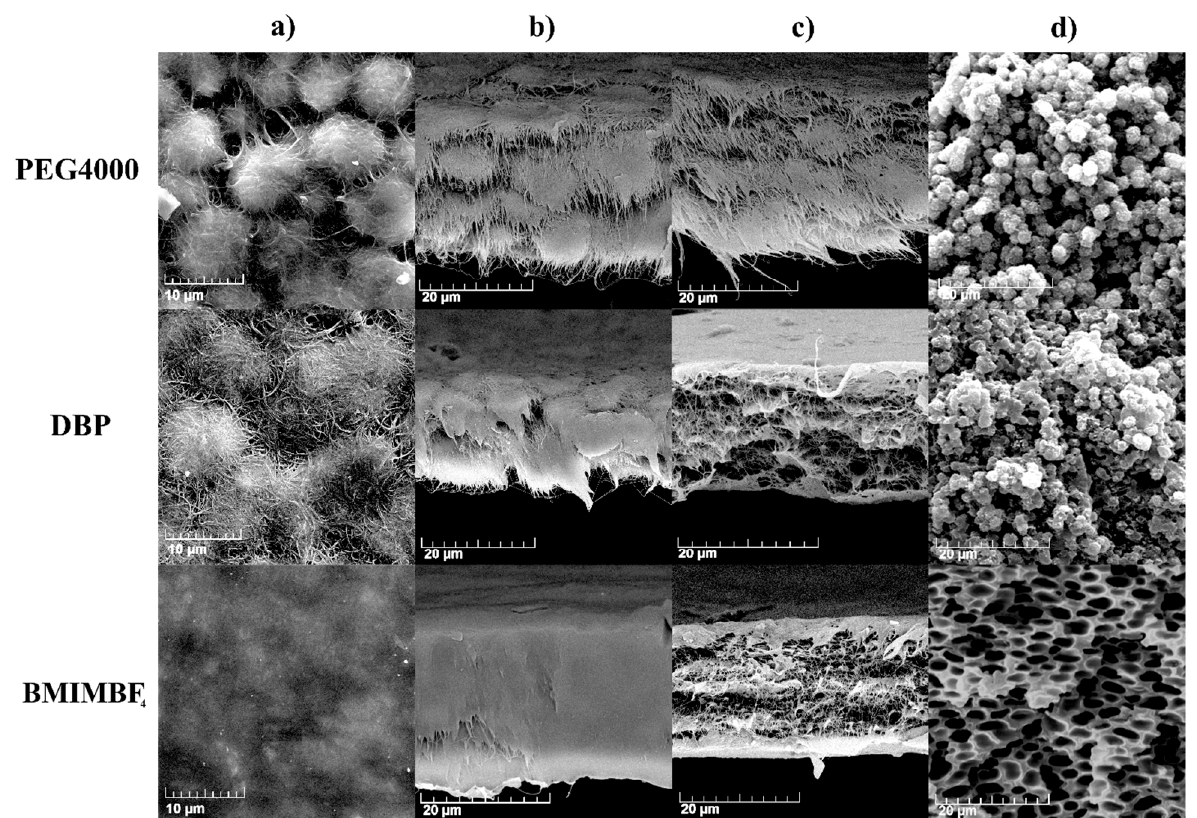
Figure 3. Micrographs of electrodes and PVDF membranes prepared with different pore-forming additives: ( a ) electrode surfaces; ( b ) cross-sections of the cut electrodes; ( c ) cross-sections of the torn electrodes; ( d ) cross-sections of the PVDF membranes.